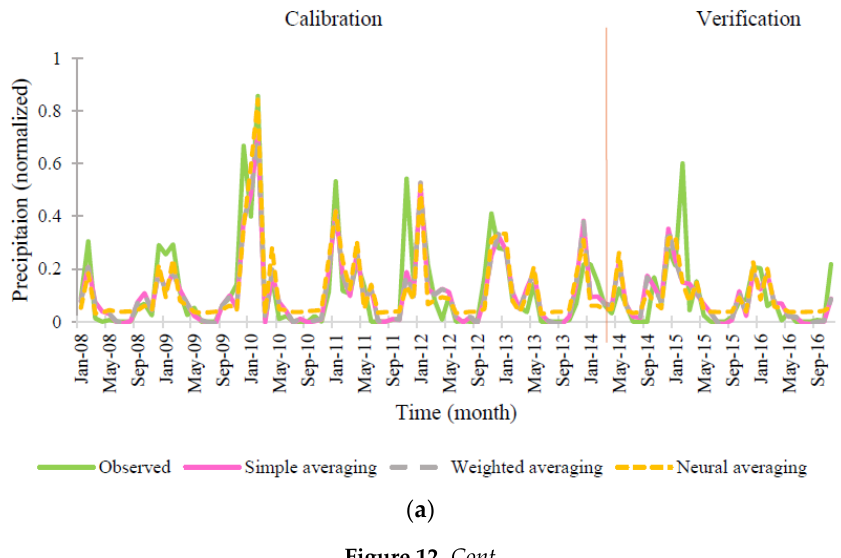
( b ) Figure 12. ( a ) Results of precipitation prediction using simple, weighted and neural averaging methods and observed precipitation; ( b ) Scatter plots for verification step using neural ensemble method based on scenario 2 for Girne station. As mentioned above, any method has its own benefits and drawbacks. Some models may provide over and some others may provide lower estimates. Also each model could estimate specific intervals more accurate than other models. Thus, by combining outputs of different methods the final estimations may be more accurate in comparison with the results of single models. It should be noticed that since the outputs of the single methods are close together (see Tables 4–6), and because the efficiency of simple and weighted averaging ensemble techniques are in the same directs with the single methods, outputs of simple and weighted ensemble techniques are quite same. As it can be seen in Tables 7–8 and Figure 12, the efficiency of neural ensemble is better than the linear ensembling methods in the most cases. For instance, the scatter plot of FFNN and neural ensemble methods based on scenario 2 for Girne station at verification step is presented by Figure 13. 0